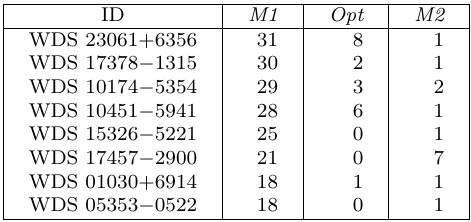
Table 3. Systems of highest prospective multiplicity. ID M1